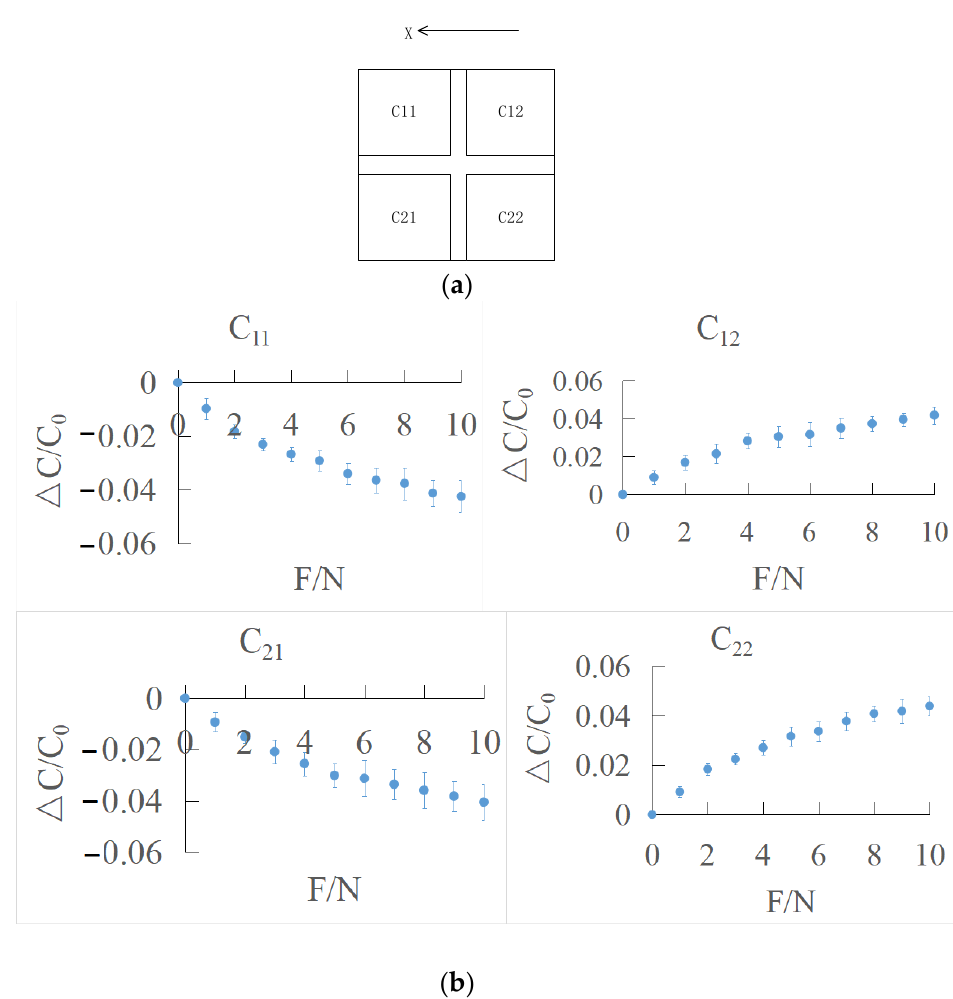
Figure 13. ( a ) Schematic diagram of X direction; ( b ) output characteristic curve of tangential force in X direction.